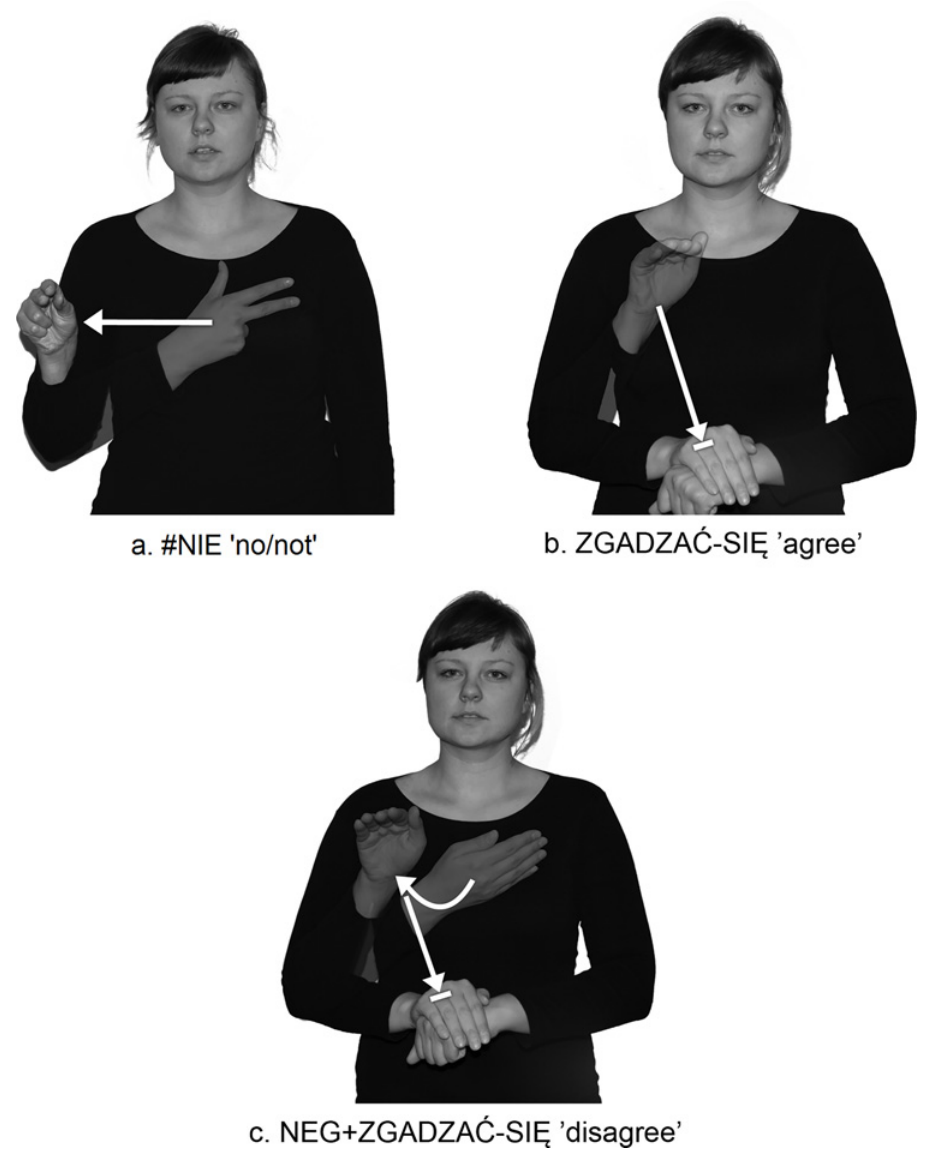
Fig 4. PJM sign ZGADZA Ć -SI Ę ‘ agree ’ with the grammaticalized negative prefix NEG-. (A) the lexicalized loan #NIE (B) the lexical base ZGADZA Ć -SI Ę ‘ agree ’ (C) prefixed sign NEG+ZGADZA Ć -SI Ę ‘ disagree ’ . The individual in this figure has given written informed consent (as outlined in PLOS consent form) to publish these case details.